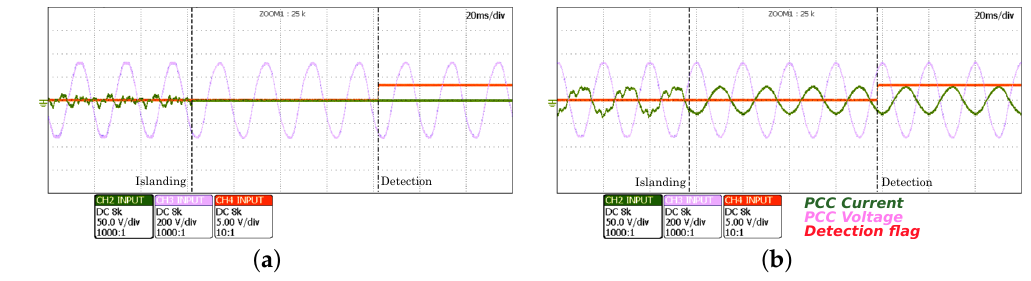
Figure 21. Experimental results under zero power flow. ( a ) Null power reference zero and no local loads. ( b ) Inverter delivered power matching with the local resonant load consumption (4.6-kW/phase).